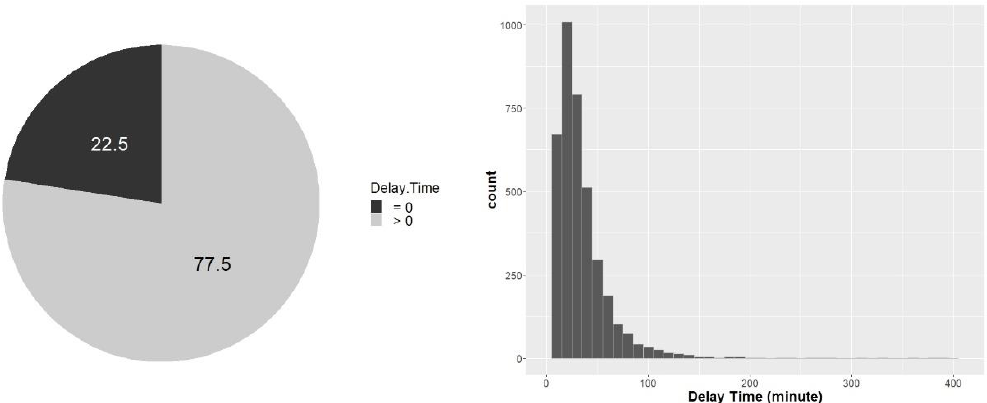
Figure 3. Distribution of Delay Time (the measurements above 400 min (0.6%) are not displayed in the histogram).